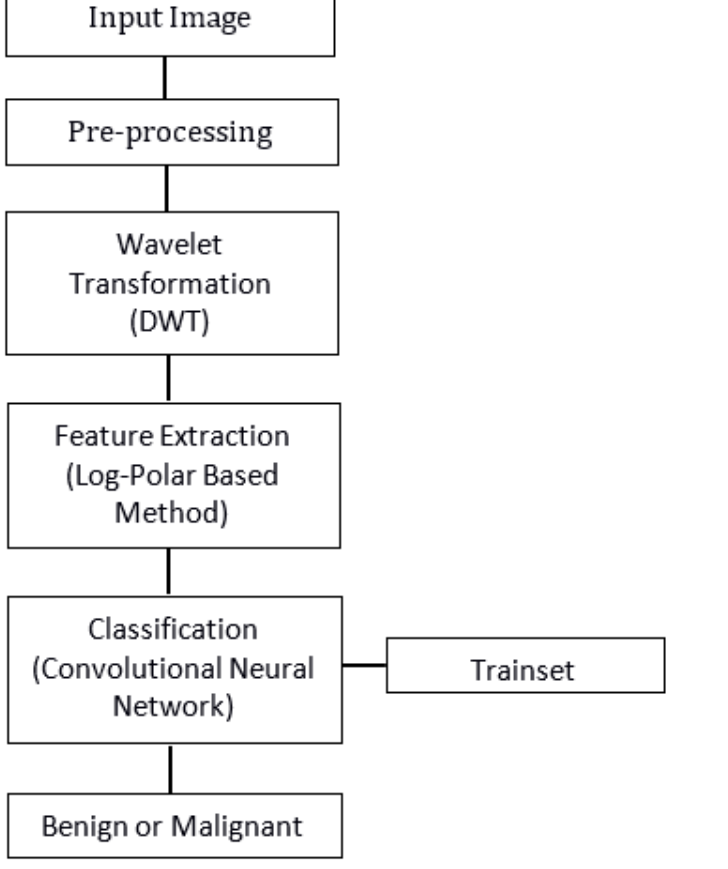
Figure 1. Flowchart of our proposed Algorithm.